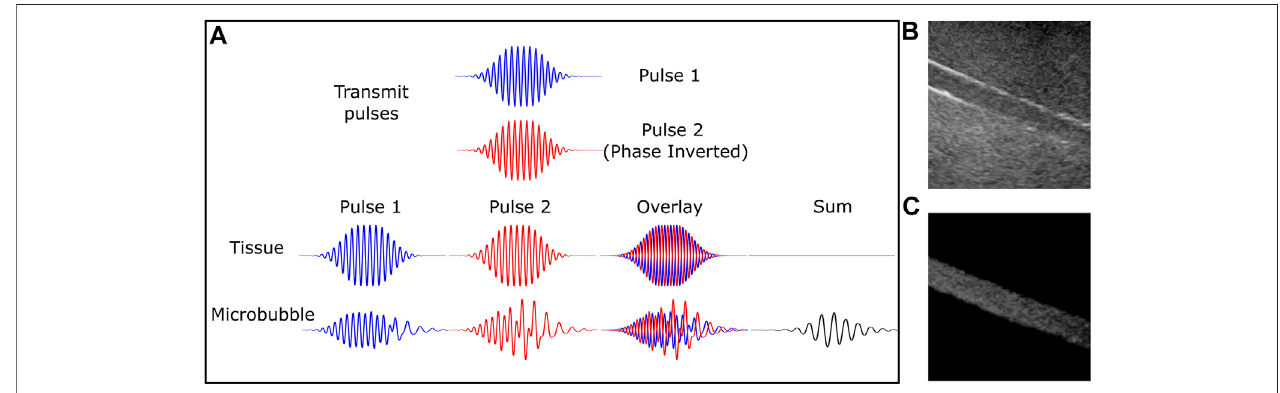
FIGURE 2 | Microbubble-speci fi c imaging sequences capture nonlinear signal from contrast agent while rejecting linear scattering tissue. (A) Schematic diagram depicting the pulse inversion technique. Two pulses that are 180 ° out of phase will result in tissue echoesthat are similarly out ofphase. However, this is not the case for microbubbles due totheirnonlinear behavior.Thesummed echoresultsinnearcompletecancellationforlineartissueand signi fi cantsignal from echoes generatedfrom microbubbles. (B) B-mode and (C) contrast-speci fi c imaging of an 8 mm vessel phantom highlights the increased vessel contrast due to microbubble-speci fi c imaging. This was acquired with a Philips iU22 scanner using a C5-2 probe and De fi nity ™ contrast